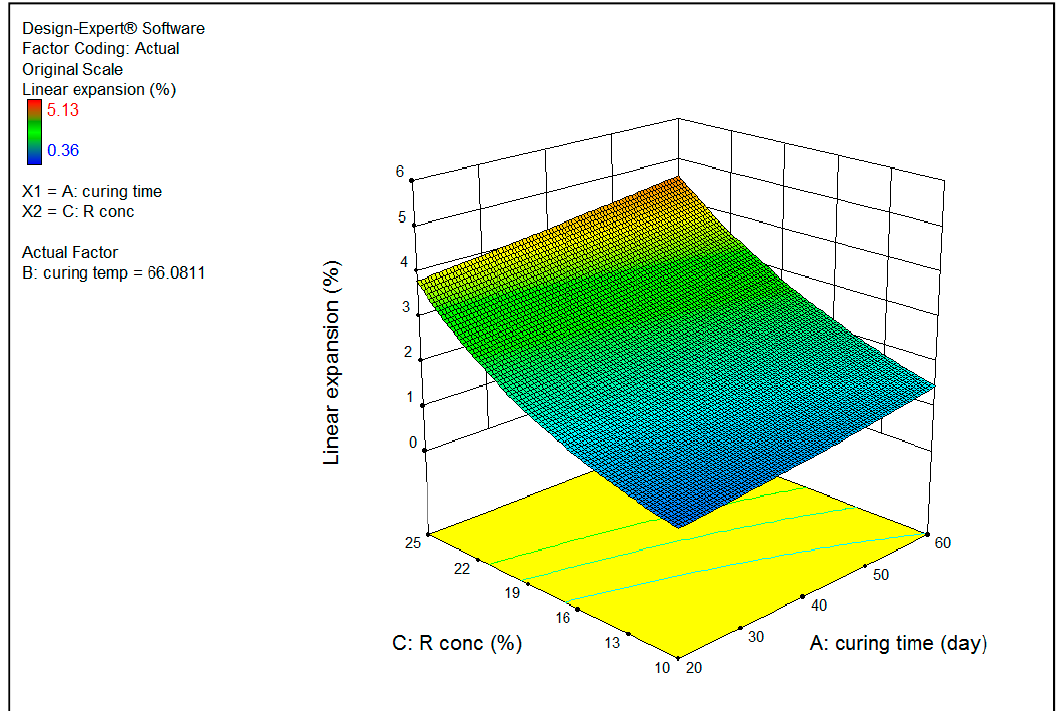
Figure 13. 3D Plot for linear expansion at 66 °C curing